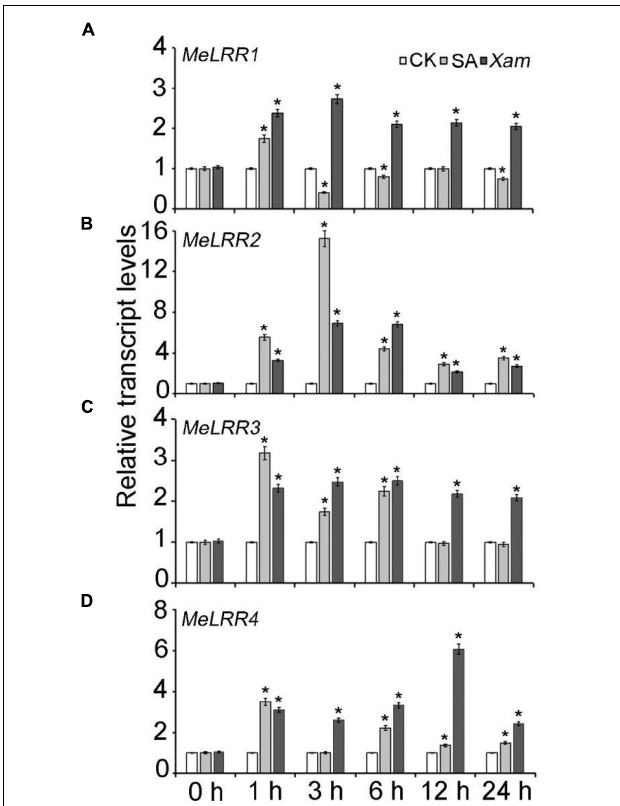
FIGURE 2 | The expression profiles of MeLRR genes in cassava in response to SA treatment and Xam inoculation. For the assays, 4-week-old cutting seedlings of cassava leaves were sprayed with water, 5 mmol/L salicylic acid, or 4 × 10 8 cfu/mL Xam suspension for 0, 1, 3, 6, 12, or 24 h. The transcript levels of MeLRR1 (A) , MeLRR2 (B) , MeLRR3 (C) , and MeLRR4 (D) at 0 h of the mock treatment was normalized to 1. Asterisks (*) indicate significant differences at p <